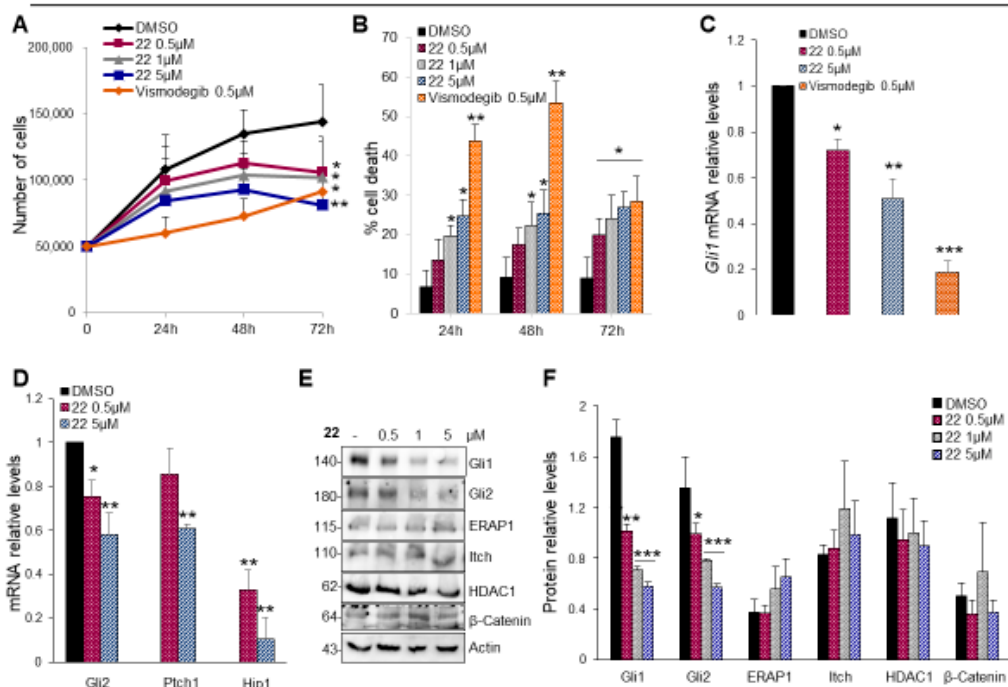
Figure 5. Hh-dependent tumor growth inhibition in vitro by compound 22 . ( A,B ) Primary cell cultures from Math1-cre / Ptch C / C mice medulloblastoma (MBs) were treated with compound 22 (0.5, 1 and 5 µ M), Vismodegib (0.5 µ M) or DMSO only. After the indicated times, a trypan blue count was performed to determine the growth rate of viable cells and the percentage of cell death. ( C,D ) Gli1 and Hh target genes mRNA levels of primary MB cells treated with compound 22 determined by qRT–PCR and normalized to endogenous control β 2-microglobulin and Hprt . ( E , F ) Representative immunoblotting and densitometric analyses of the indicated proteins in primary MB cells after the treatment with compound 22 . Data show the mean ± SD of three independent experiments. (*) p < 0.05 vs. DMSO; (**) p < 0.01 vs. DMSO; (***) p < 0.001 vs. DMSO.